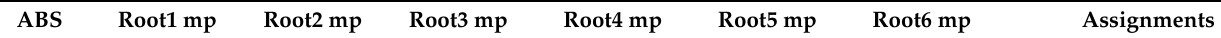
Table 4. Fluctuating Raman peaks (cm − 1 ) and their assignments as detected in the later developmental stages of radish root